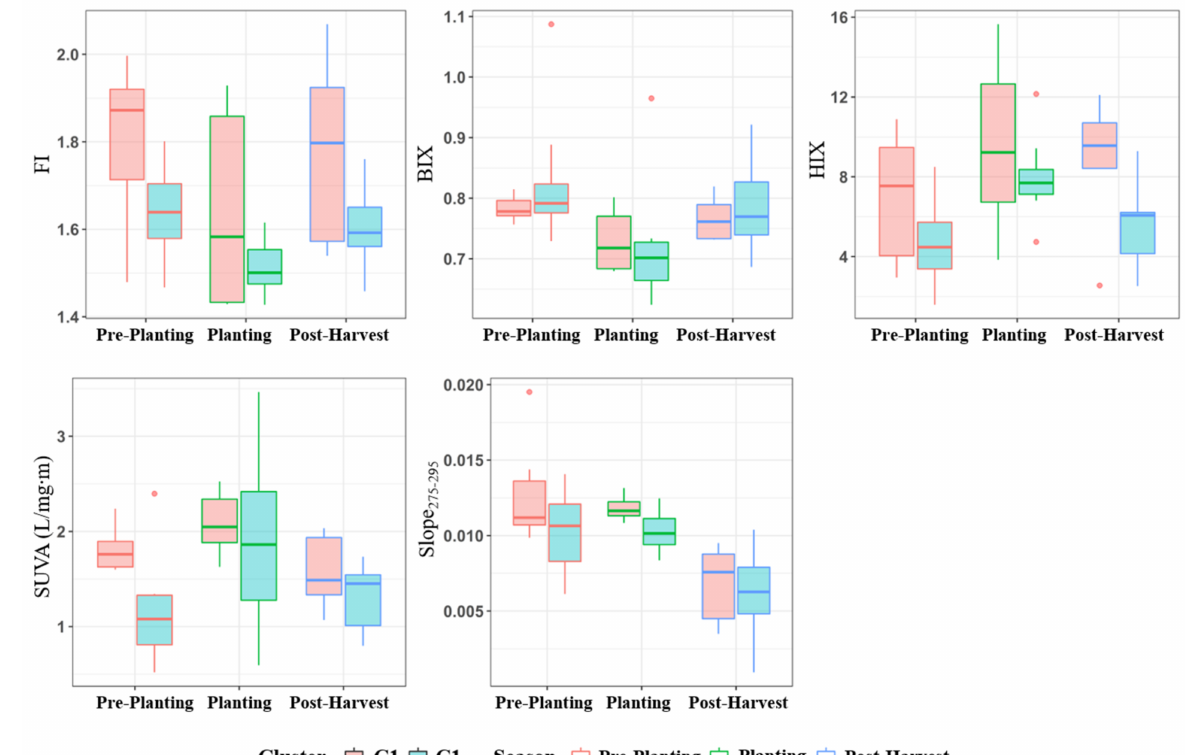
Figure 7. Analysis results for fluorescence and spectroscopic indices according to the two clusters and farming